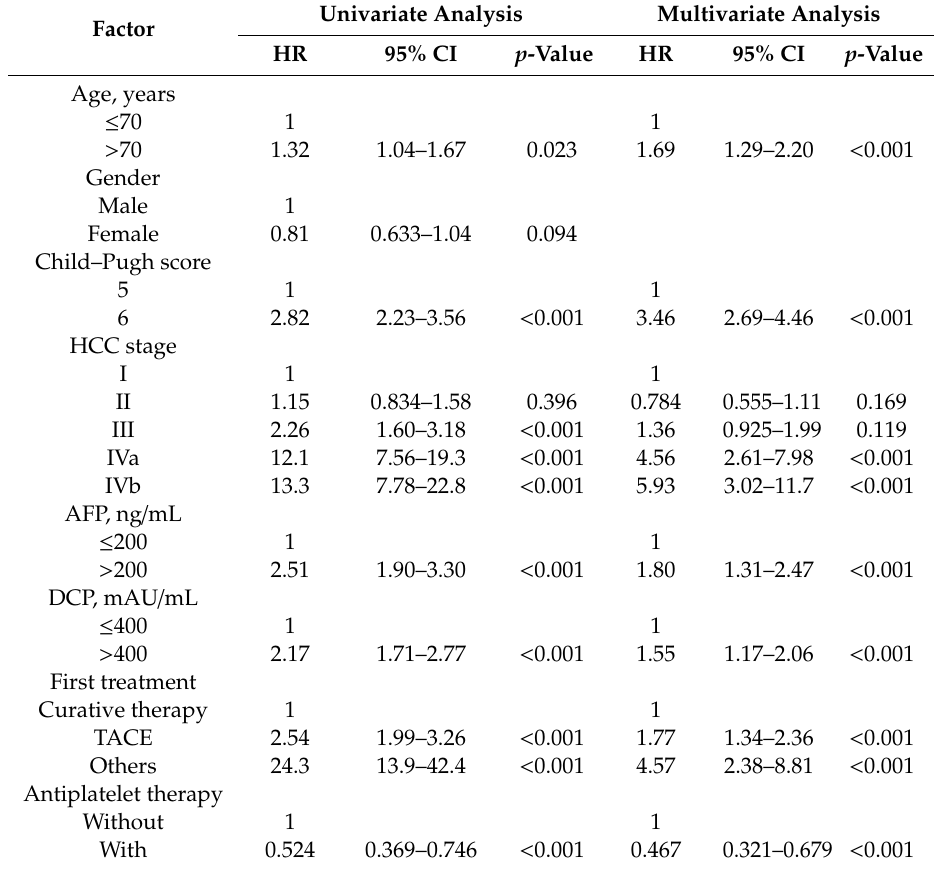
Table 4. Baseline factors associated with Child–Pugh deterioration in patients with Child–Pugh grade A liver disease at baseline in univariate and multivariate Cox regression analyses.